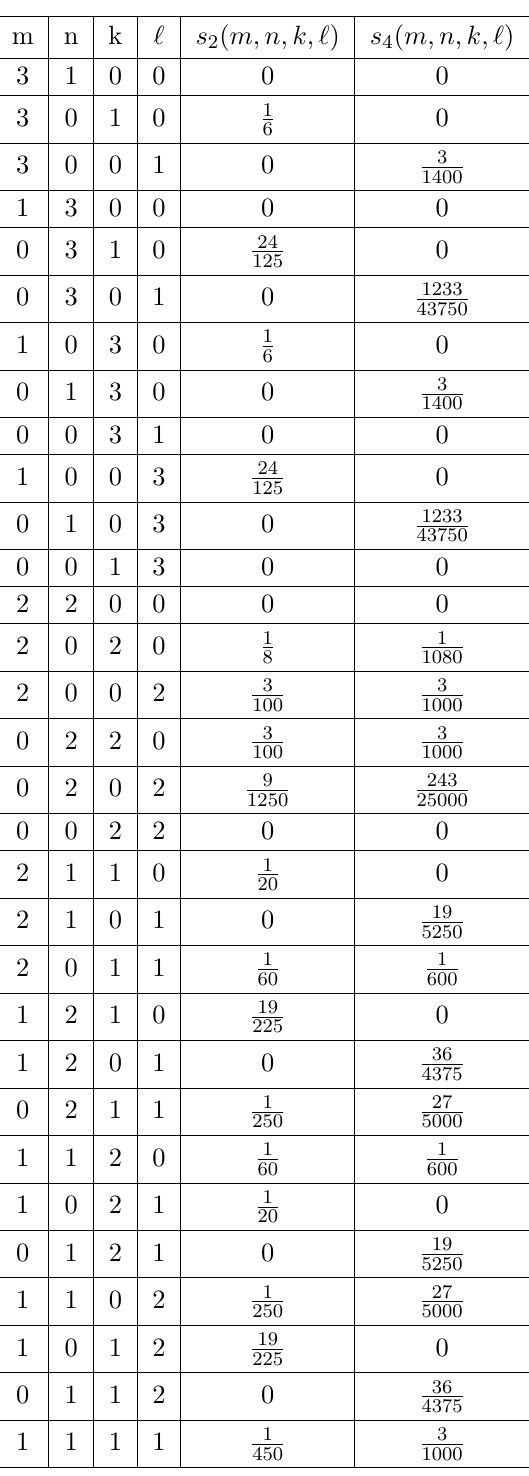
Table 2 . Coe(cid:14)cients